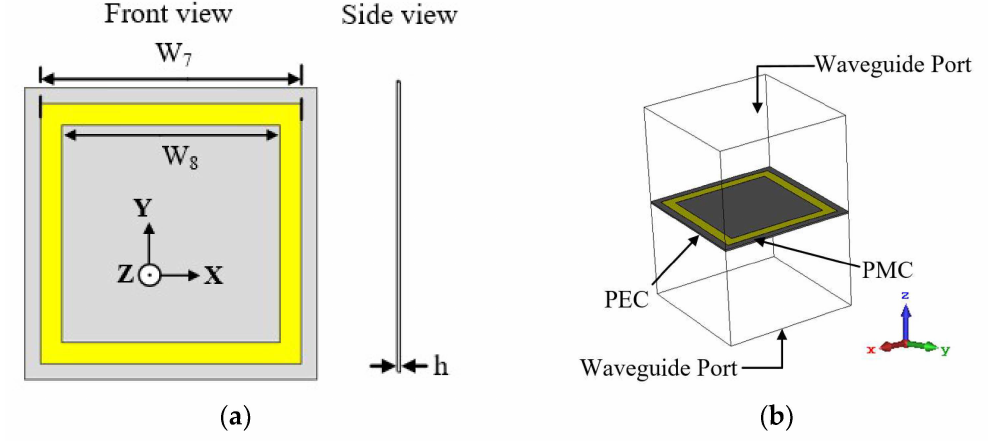
Figure 7. Geometry of proposed FSS unit cell: ( a ) 2D view and ( b ) 3D view of simulation